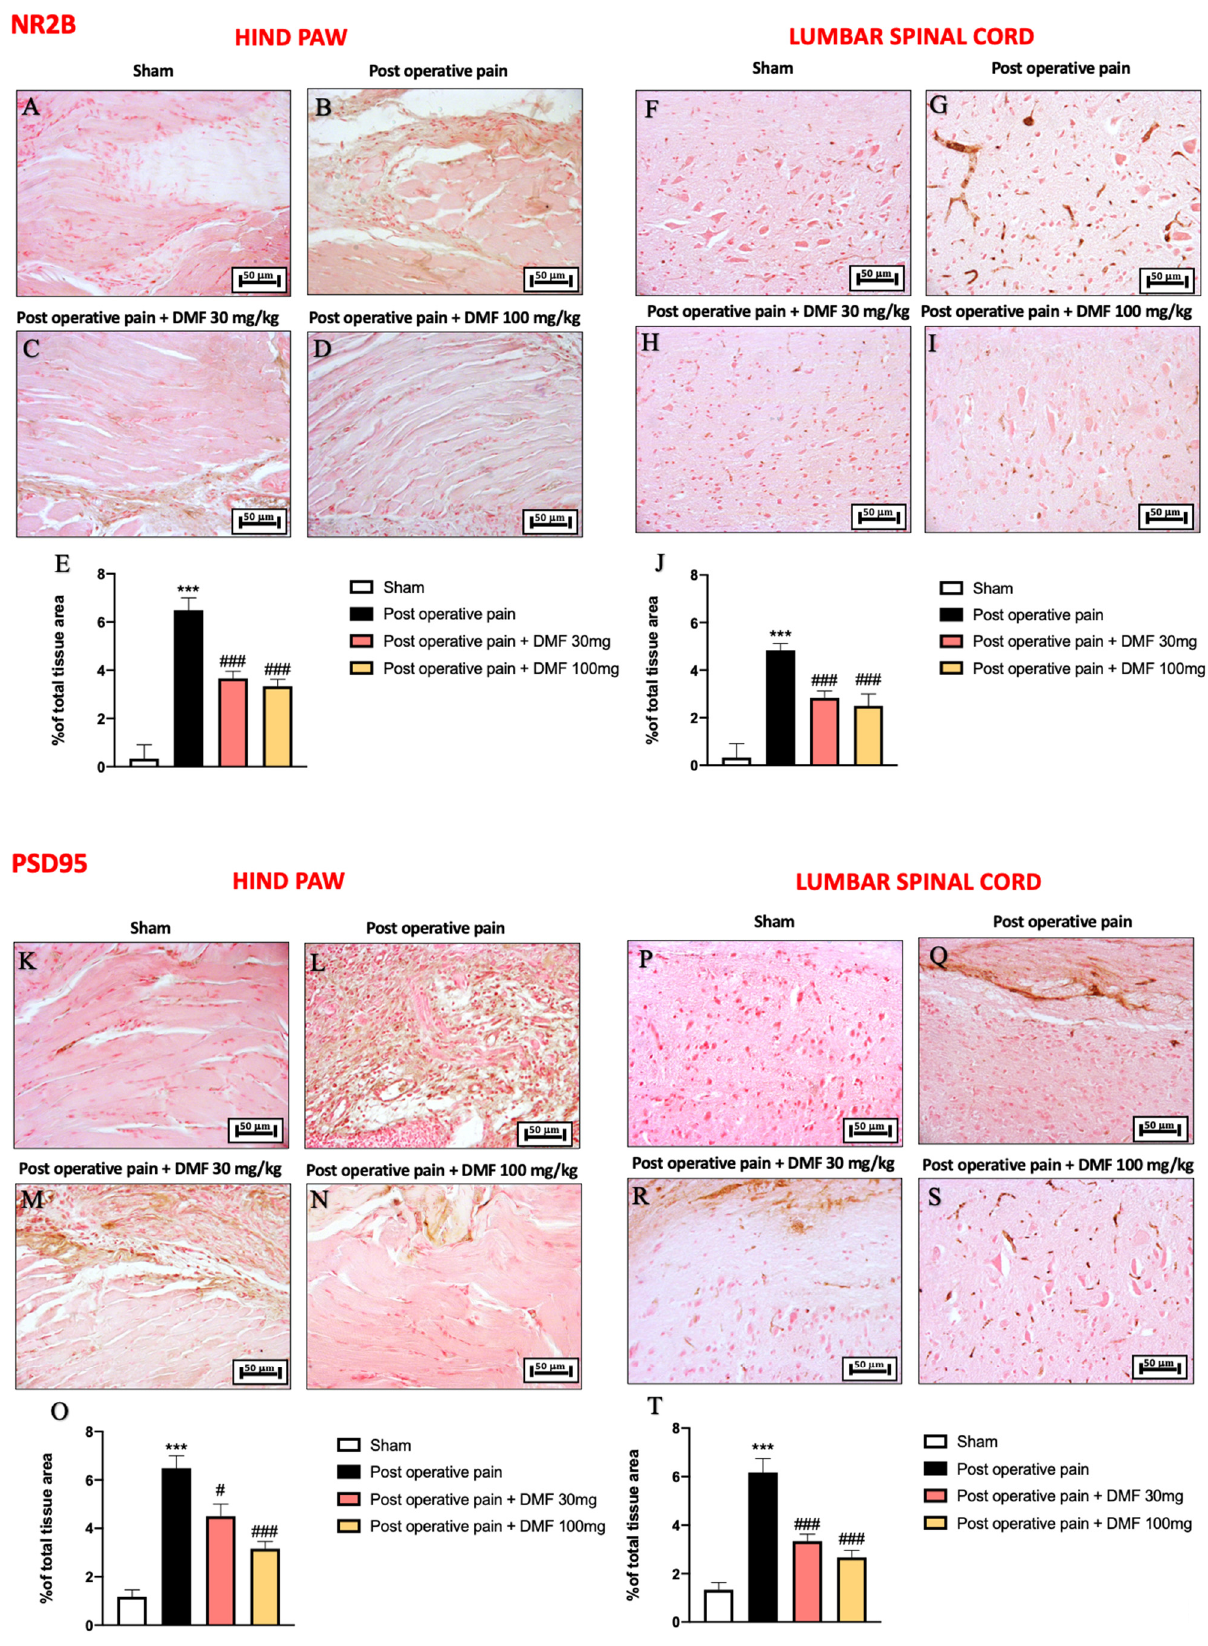
Figure 6. DMF treatment modulated NMDA pathway. Immunohistochemical analysis of NR2B on hind paw tissue: sham ( A ), PO pain ( B ), DMF 30 mg/kg ( C ), DMF 100 mg/kg ( D ), score ( E ). Immunohistochemical analysis of NR2B lumbar spinal cord tissue: sham ( F ), PO pain ( G ), DMF 30 mg/kg